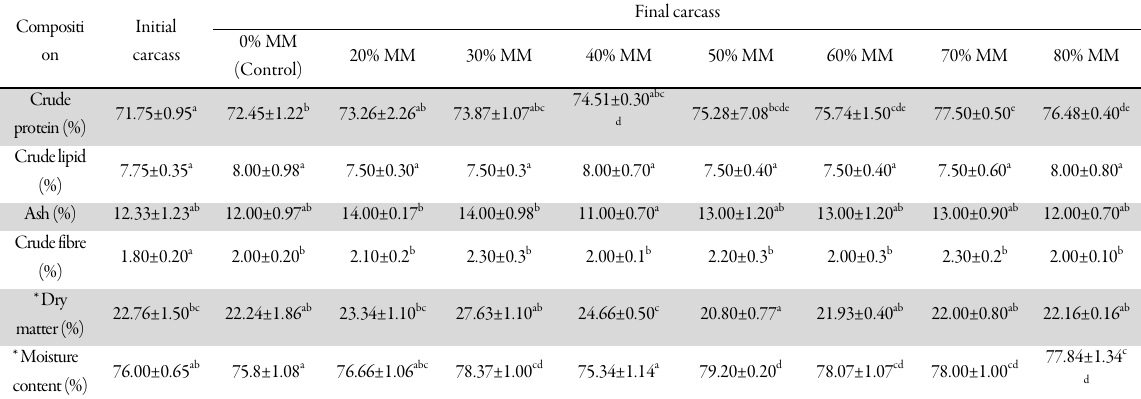
Table 5. Carcass composition of experimental fish fed the different diets at the beginning and end of feeding trials (% dry weight)